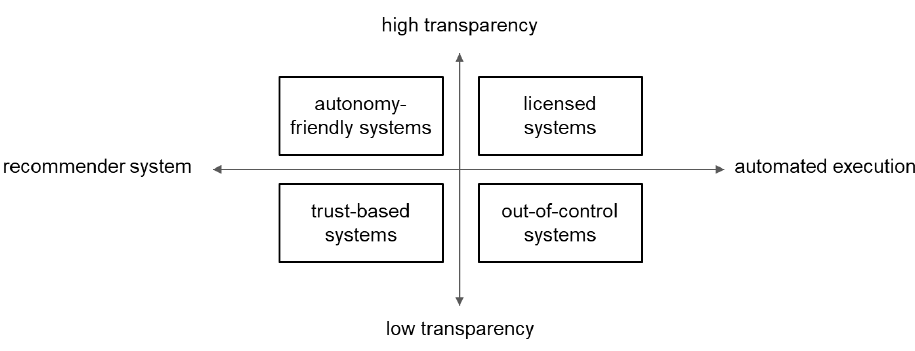
Figure 1: Types of algorithmic governance